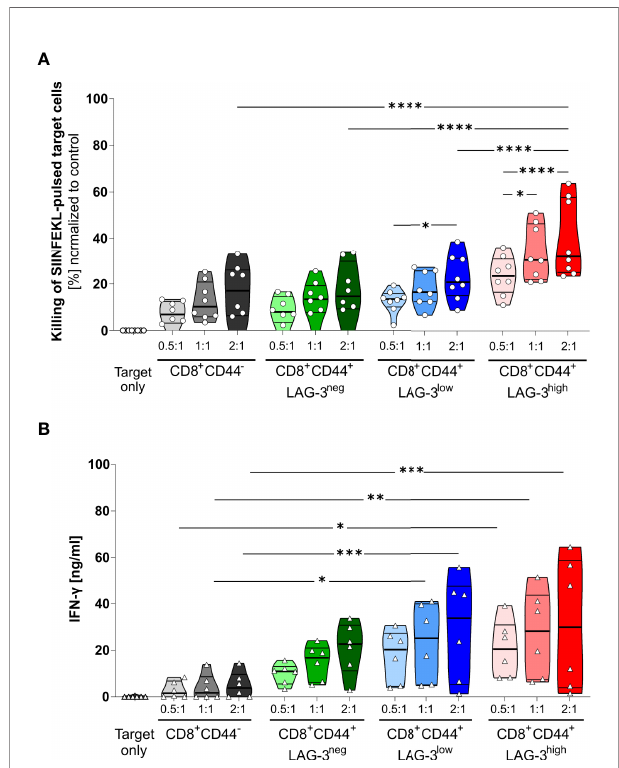
FIGURE 4 | LAG-3 expression correlates with cytotoxic capabilities of CD8 + T cells. (A) Killing of SIINFEKL (SII)-pulsed target cells by CD8 + CD44 + T cells expressing different levels of LAG-3 compared to CD8 + CD44 - T cells in a dose dependent manner. SIINFEKL-pulsed target cells obtained from C57BL/ 6J mice were co-incubated with indicated sorted CD8 + T cells in indicated ratios for 6 hours. CD8 + T cells were obtained from OT-I mice infected with PbTG 6 days prior to T cell isolation. (B) Secretion of IFN- g of the above- mentioned CD8 + T cells subsets from the supernatant of the cytotoxicity assay. Each dot represents the mean of up to two technical replicates. Data were tested for normal distribution with the Anderson-Darling test with a pass for normality of alpha=0.05. ANOVA with Tukey test for multiple comparisons. P= * < 0.05, ** < 0.01, *** < 0.001, **** < 0.0001, (A) n = 8, (B) n = 6. All groups showed signi fi cant (P < 0.05) killing compared to the target only group; these signi fi cances are not shown to avoid overloading the fi